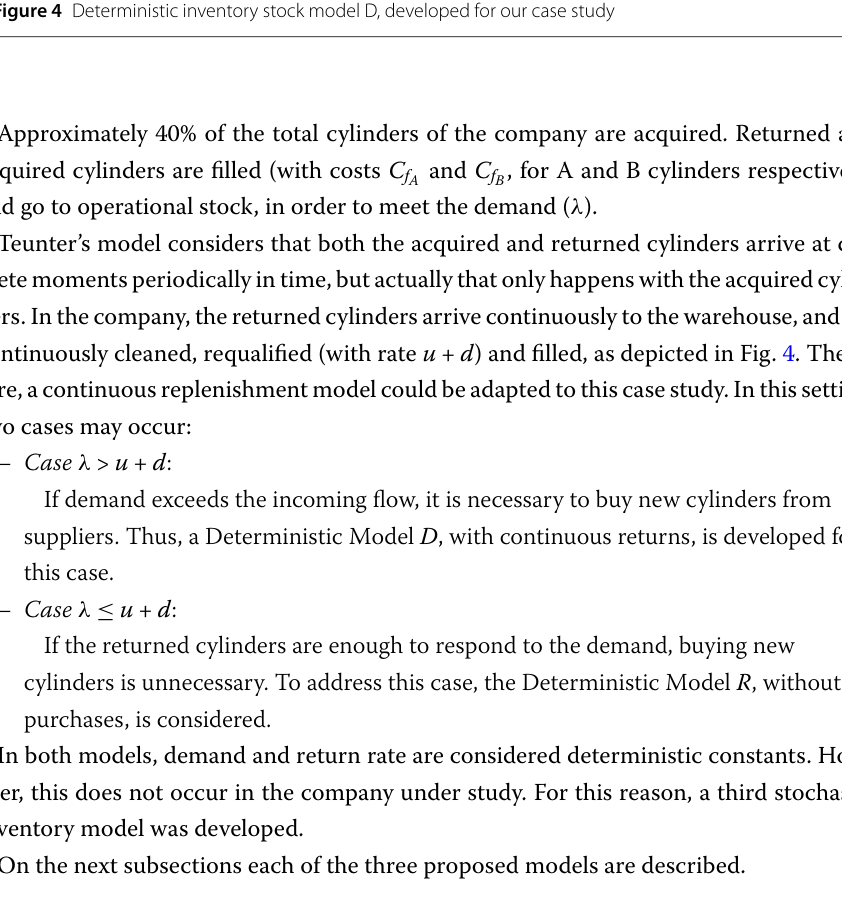
Figure 4 Deterministic inventory stock model D, developed for our case study